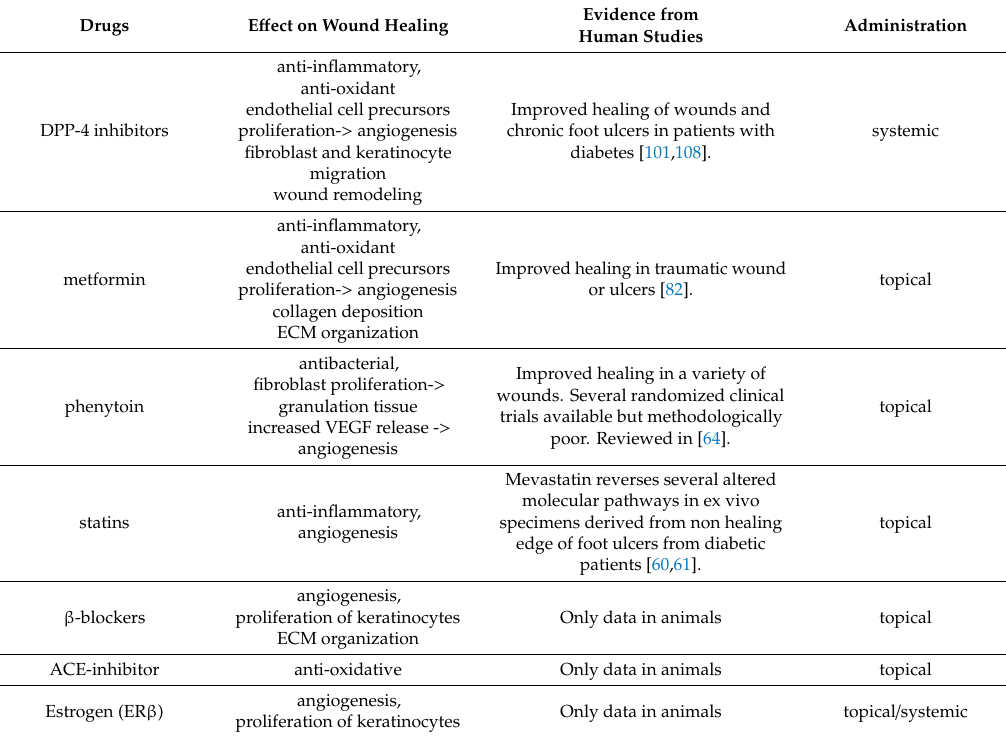
Administration systemic topical topical topical